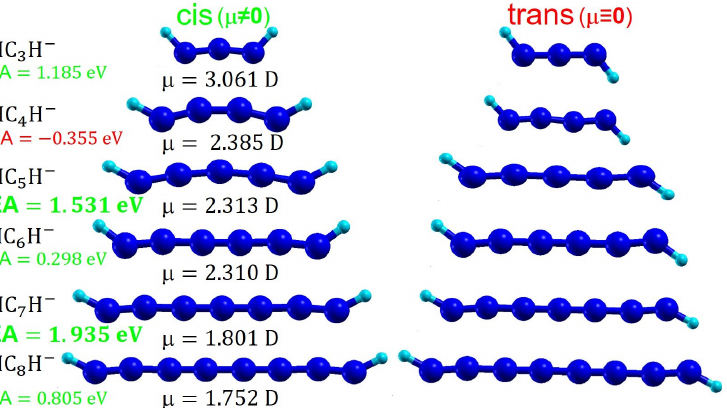
Figure 2. In contrast to the linear conformers, which are unstable against H–C–C bending vibrations at the two molecular ends, cis and trans HC n H – anion isomers with n ≤ 8 correspond to local energy